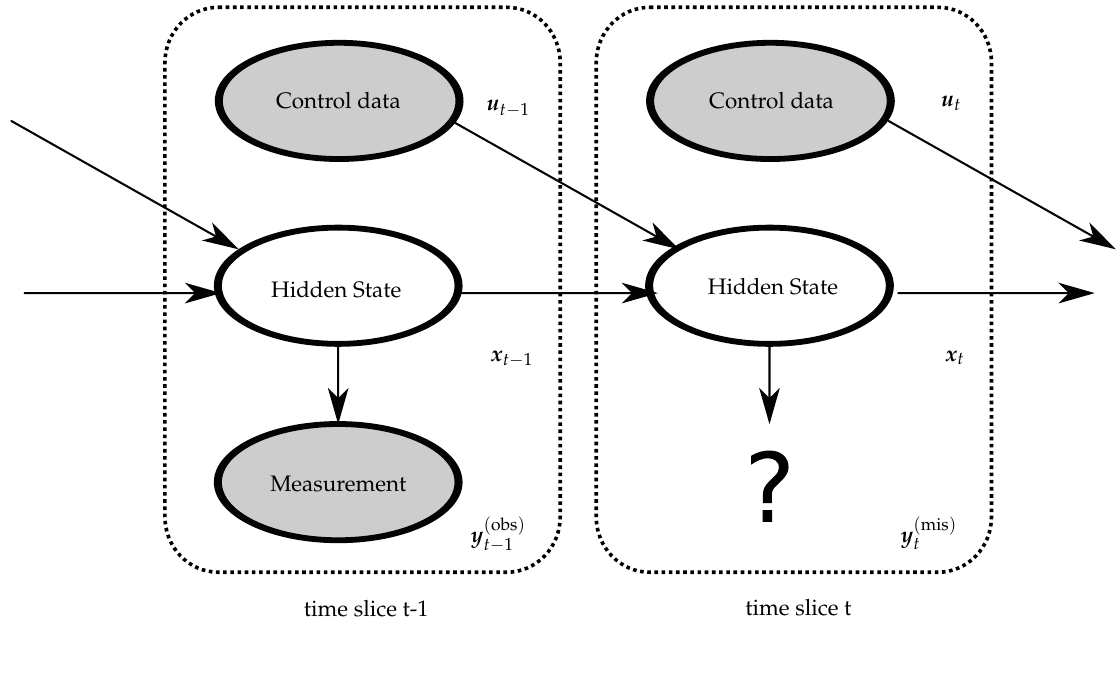
Figure 1. Two time slice Bayesian network with missing measurement